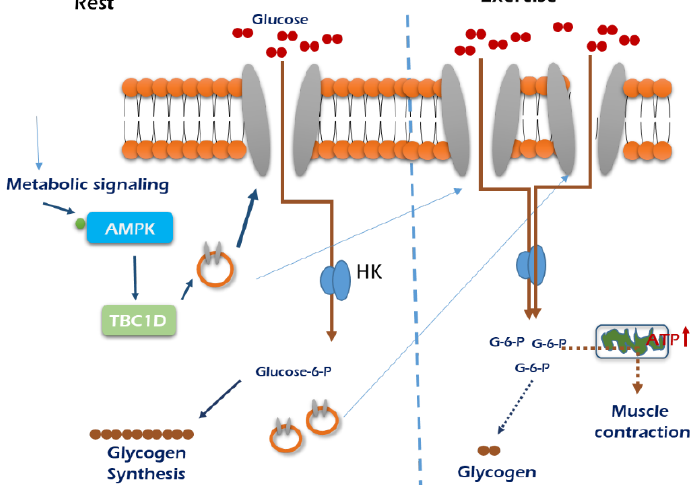
Figure 3. An exercise-stimulated glucose uptake in skeletal muscle. Glucose demands are minimal when muscle is in the resting stage, so glucose delivery is low. When exercising, muscle preferentially uses glycogen to supply glucose for the generation of ATP to meet increased metabolic demands. Skeletal muscle glucose uptake during exercise is mainly regulated from flux though intracellular metabolism. Under normal submaximal exercise conditions, skeletal muscle glucose uptake appears to be limited by glucose transport through the cell membrane. The mechanism stimulates GLUT4 translocation and glucose uptake appear to arise from activation of AMPK.